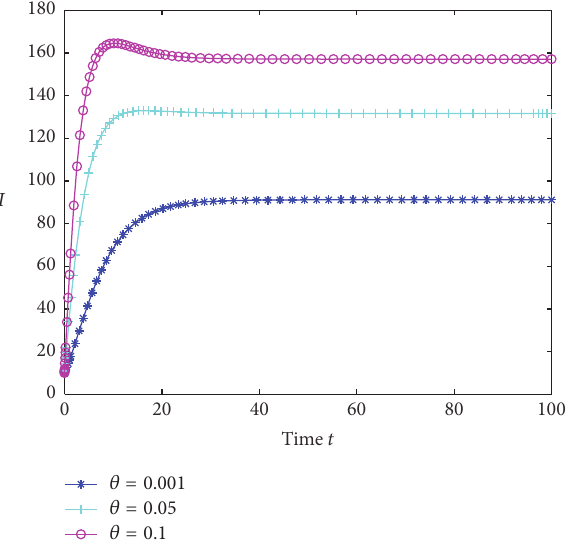
Figure 4: An illustration of the impact of 𝜃 on 𝐼(𝑡) for system (1) given in Example